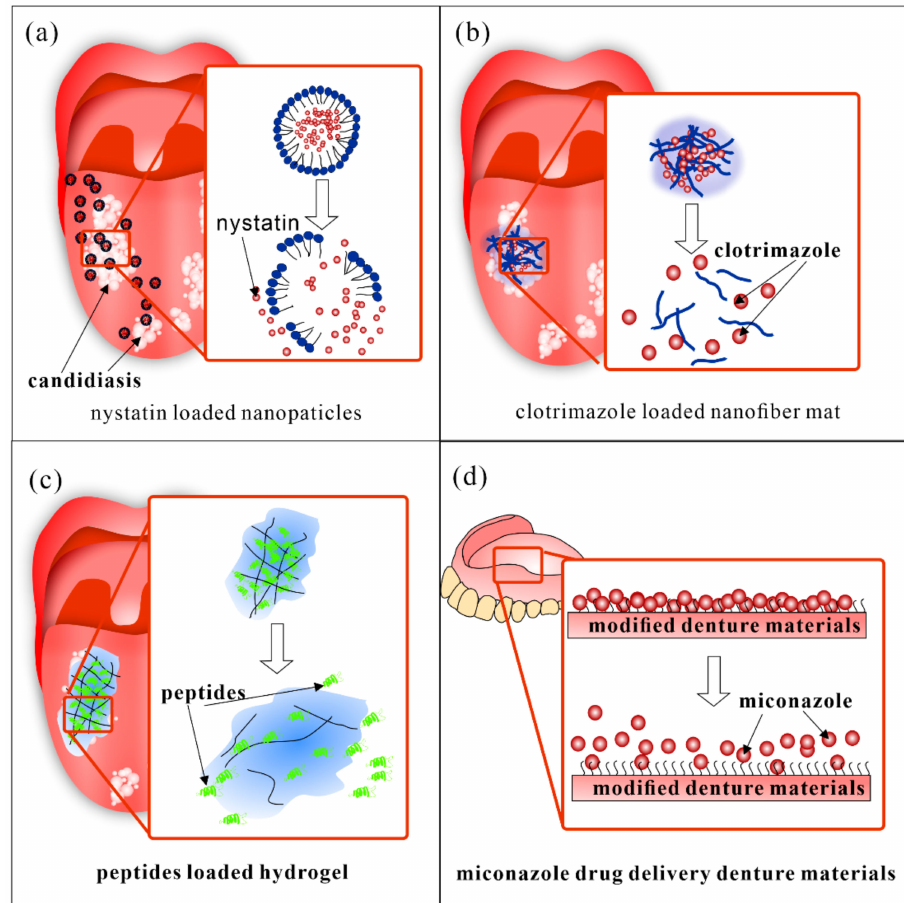
Figure 6. Recent DDS for oral candidiasis. ( a ) nystatin loaded lipid based nanoparticles, ( b ) clotrimazole loaded nanofiber mat; ( c ) Peptides loaded bioadhesive hydrogel; ( d ) modified denture materials with sustained drug release. The copolymer modified denture could had improved binding with miconazole and thus showed sustained drug